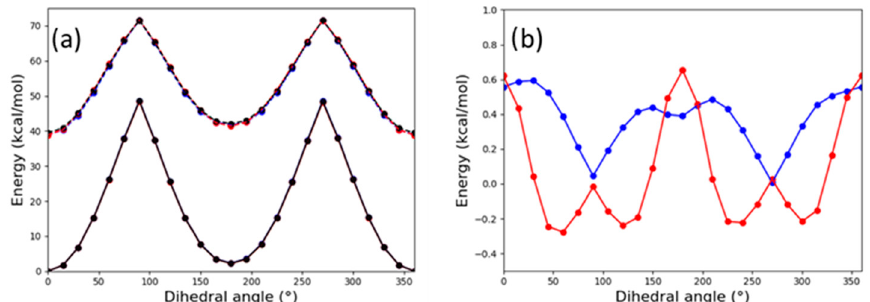
Figure A2. Superposition of structures with θ = 0° (blue), 45°, 90°, 135°, 180° (red). Colour code: S, yellow; C: grey. Hydrogen atoms are omitted for clarity. The structures have not been reoptimized for each studied dihedral angle.